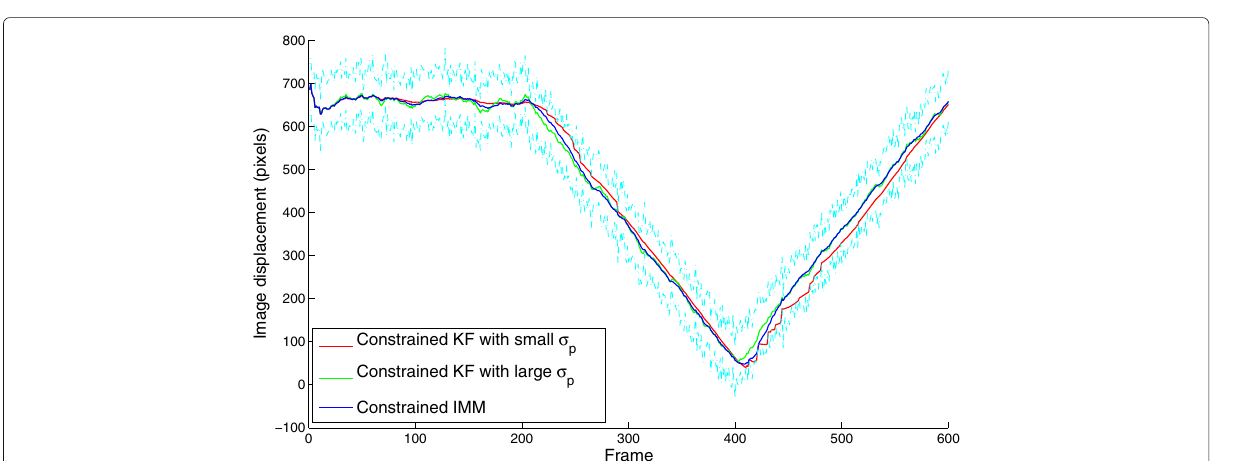
Fig. 4 Synthetic simulation: comparison between single-model constrained Kalman filtering and constrained IMM. Cyancurves are constraint boundaries